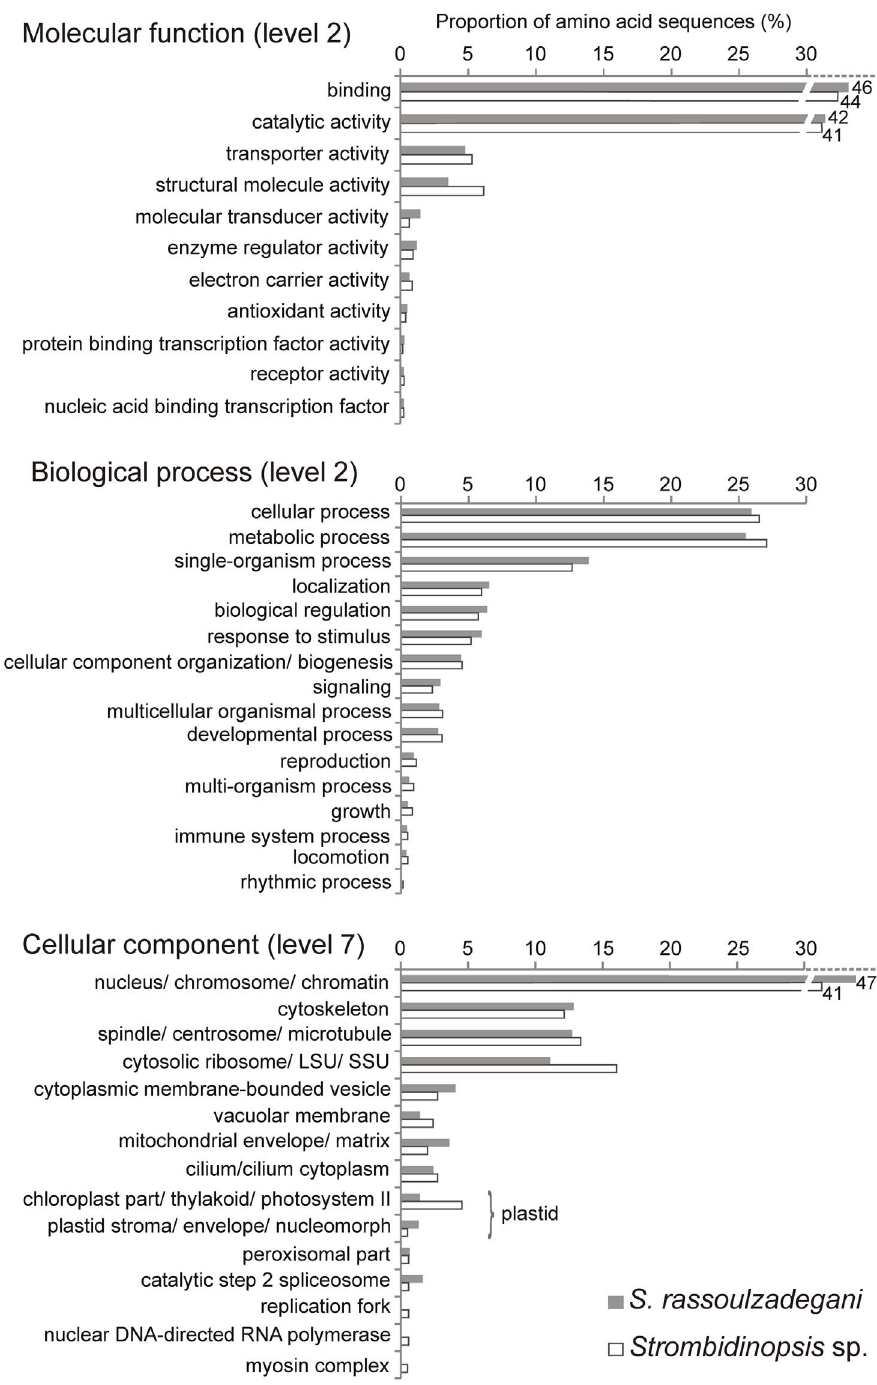
Figure 3. Gene Ontology terms distribution in ciliate transcripts.